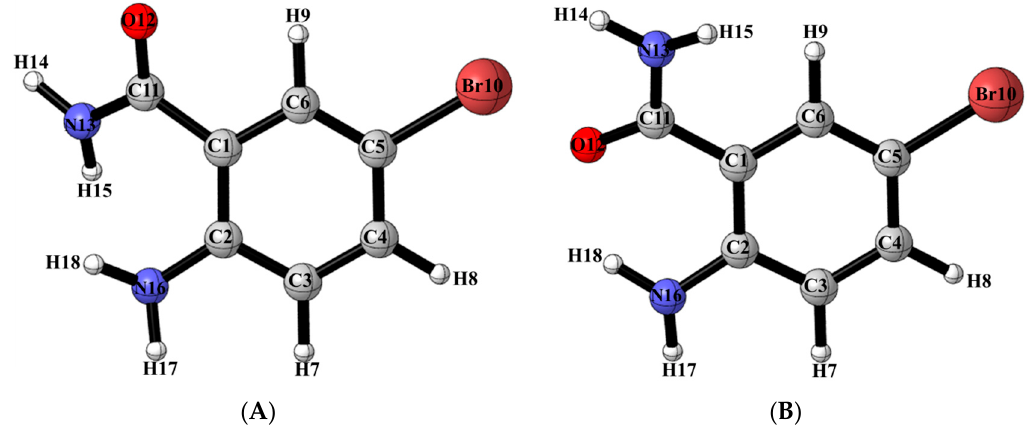
Figure 2. Geometry optimized conformers ( A ) and ( B ) of ABB in the solution phase.